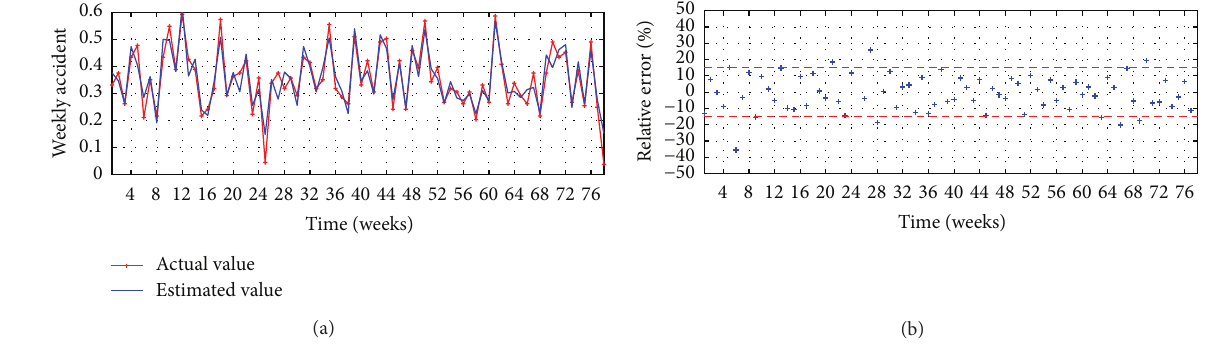
Figure 8: MA-ANN-PSO(9,10,1): (a) observed versus estimated and (b) relative error.